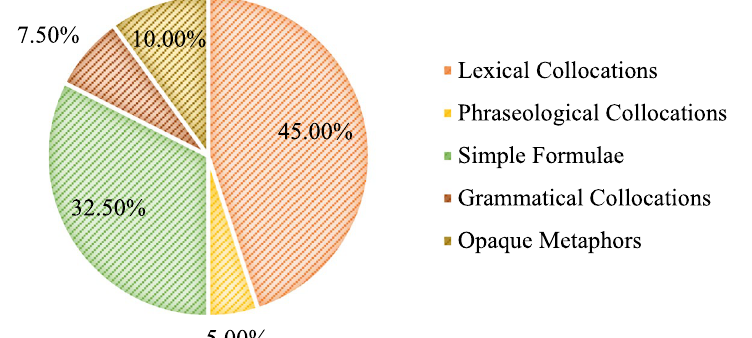
Fig. 8 Percentages of each phraseological unit type used in band score 7